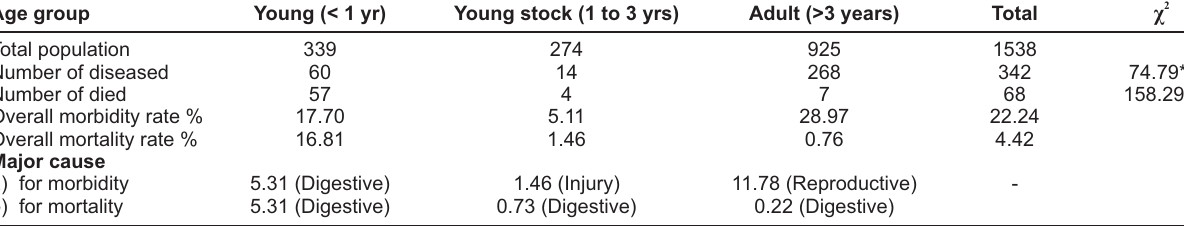
Table-3. Age-wise morbidity and mortality rates in cattle Age group